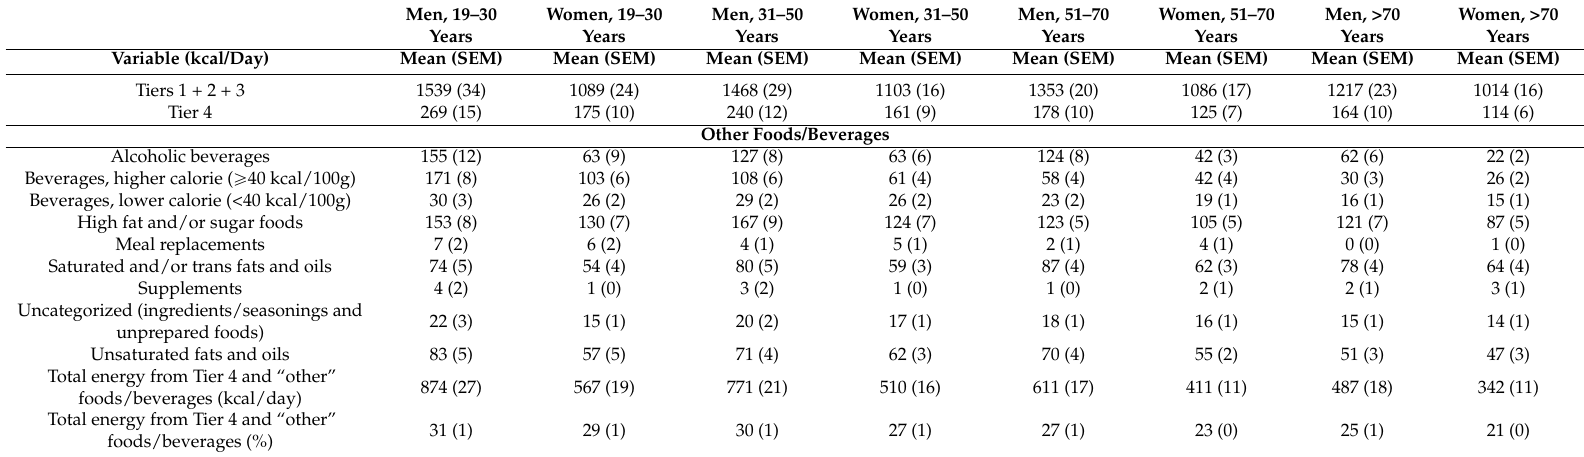
Table 2. Weighted analysis of energy contribution from Tiers 1–3 foods (compliant with Eating Well with Canada’s Food Guide (EWCFG)) [9] and Tier 4 and “other” foods and beverages not included in the EWCFG [9] among Canadian adults ( ě 19 years)